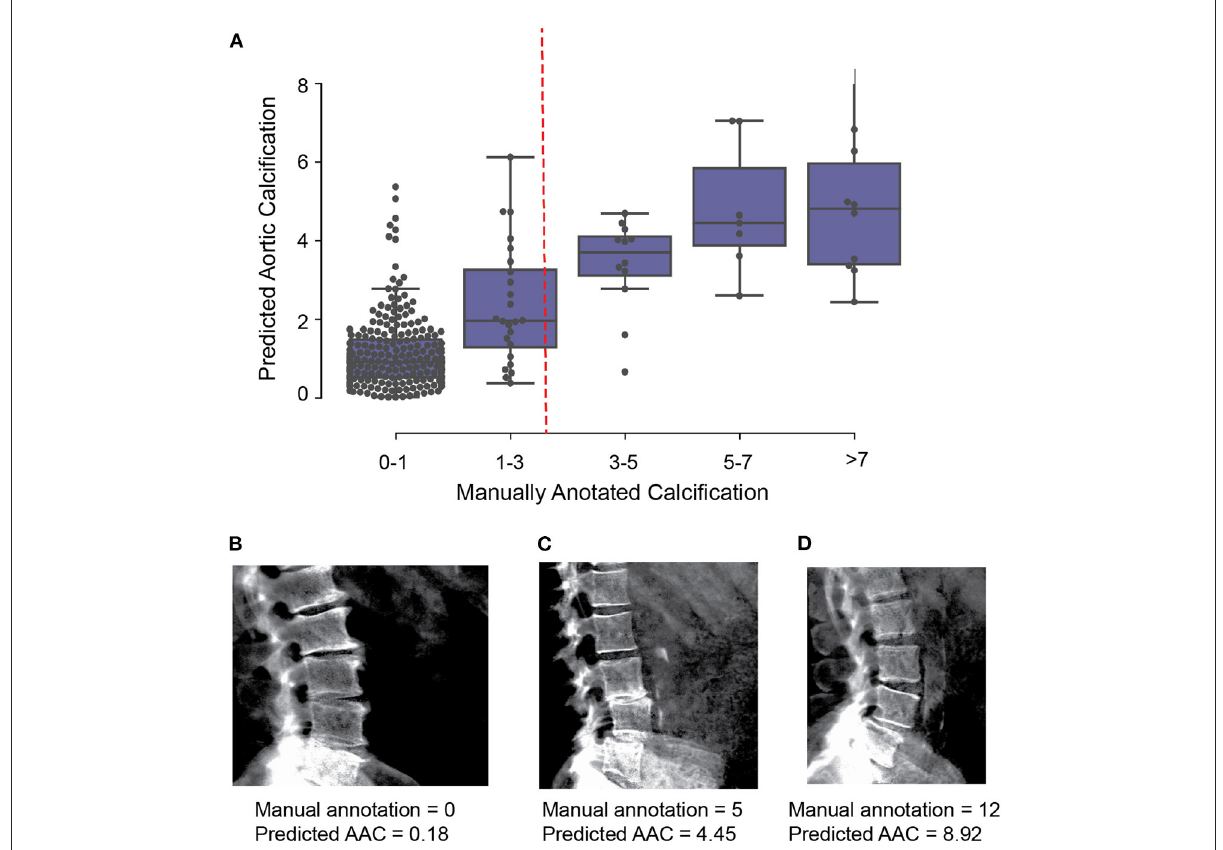
FIGURE3 Comparison of machine learning based AAC scores to manually annotated AAC scores. (A) Correlation of manually annotated calcification scores with ensemble machine learning (ML) scores on the 300 images in the validation set. (B–D) Comparison of ML and manual scores for participants with low, medium and high levels of calcification within the test